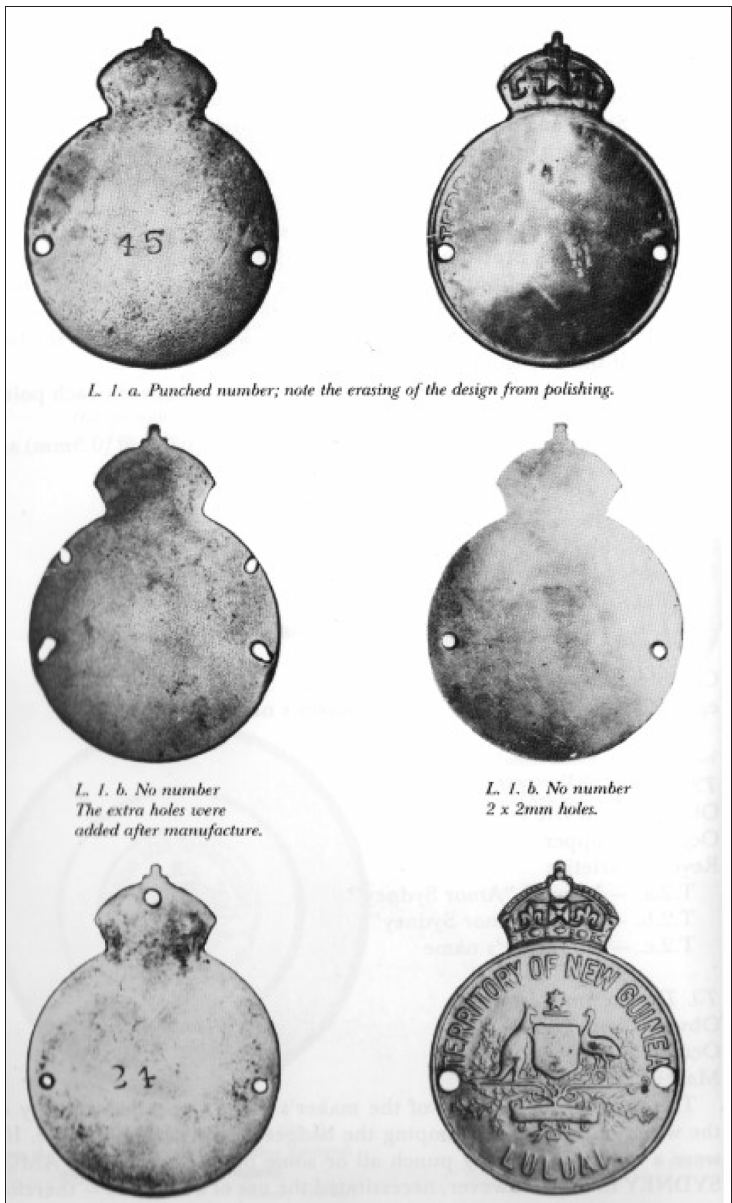
Figure 1: The luluai system was considered a huge success by the colonizers, and, as such, it remained intact after the British/Australian administration took over the colony from Germany in 1914. The luluai badges issued by the Australian colonial government show traces of frequent use, which testify to the meaning attached to them well into this later period. Worn surfaces, punched numbers on the back, and additional drilled holes attest to extensive use. Mira, From Cowrie to Kina ,